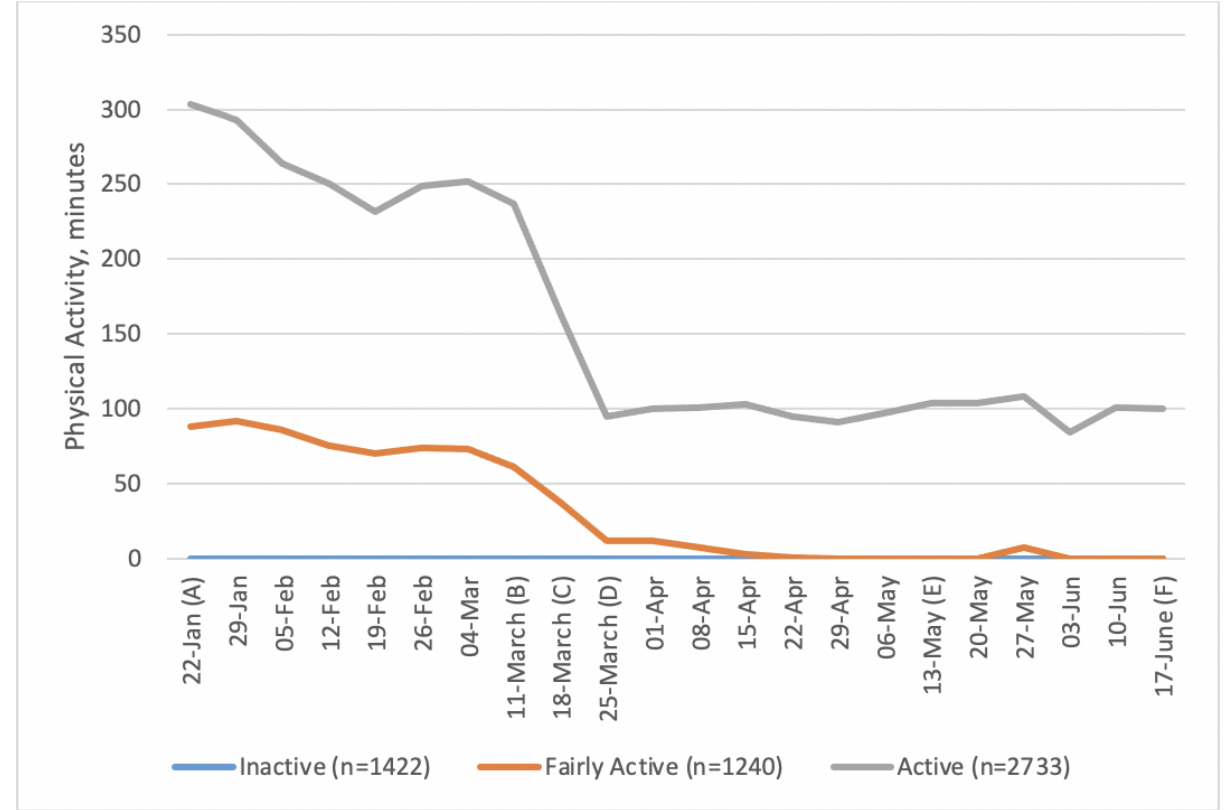
Figure 4. Weekly minutes (median) of activity by physical activity level at baseline. Important dates are marked on the x-axis as follows. (A) January 22: Baseline, week before first COVID-19 case announced in the United Kingdom. (B) March 11: Social distancing measures introduced. (C) March 18: Lockdown begins. (D) March 25: First full week of lockdown. (E) May 13: Lockdown measures relaxed. (F) June 17: Shops